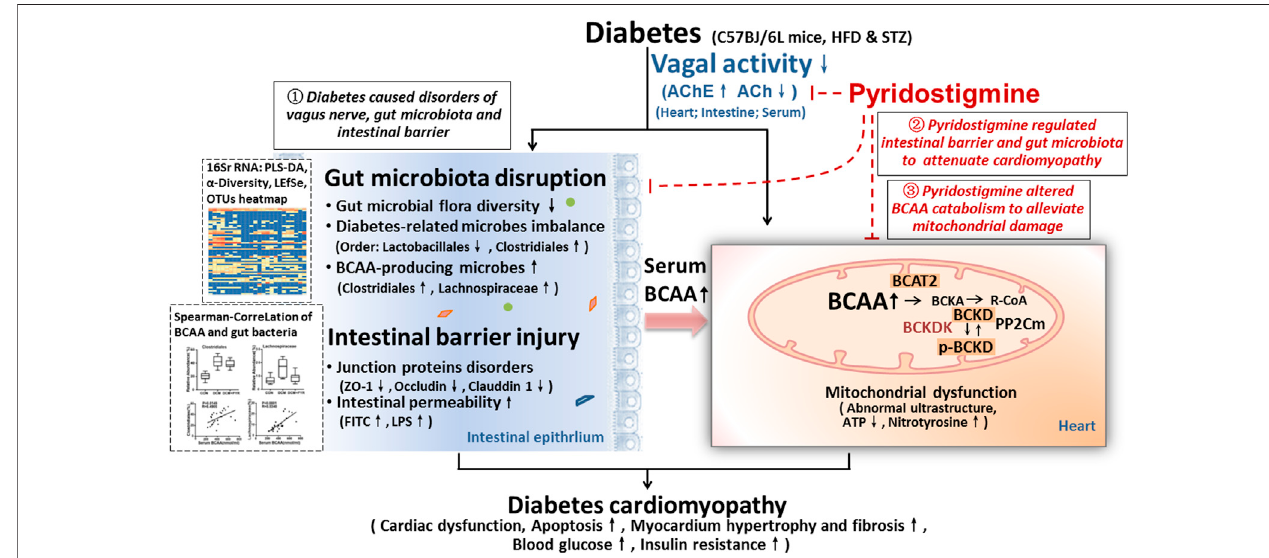
FIGURE 8 | Illustration of the effect of pyridostigmine on diabetic cardiomyopathy and the proposed mechanism. (1) Intestinal barrier function (related to TJs and intestinal permeability) and gut microbial homeostasis (diabetes-related and BCAA-producing microbes) were impaired in diabetic cardiomyopathy mice, and this impairment was accompanied by reduced vagal activity, which eventually led to cardiac damage. (2) Pyridostigmine enhanced vagal activity and alleviated intestinal barrier injury and gut microbiota disruption, thereby reducing BCAA levels and ameliorating cardiac damage. (3) More importantly, BCAA catabolism was decreased in cardiac tissue in the context of diabetes, whereas pyridostigmine regulated BCAA catabolism enzymes to decrease cardiac BCAA concentrations and alleviate mitochondrial